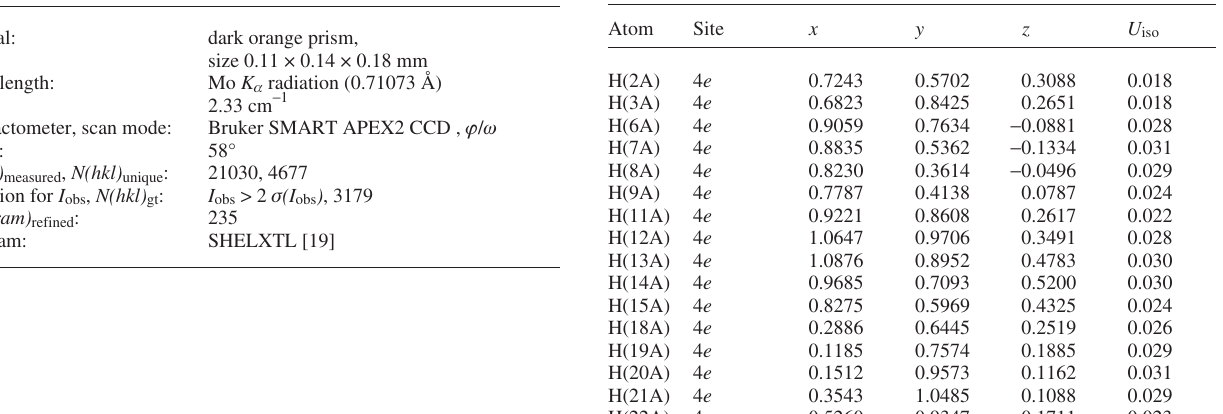
Table 2. Atomic coordinates and displacement parameters (in Å 2 ) . Table 1. Data collection and